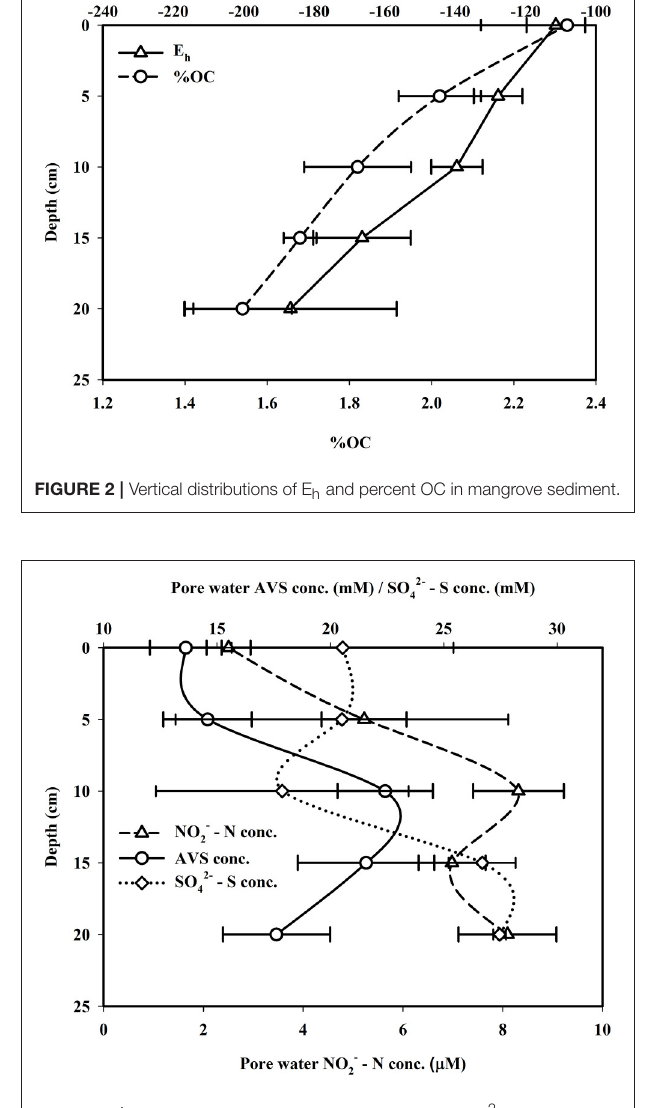
with patterns of peak sulfate reduction, with methanogenesis occurring deeper in the sediments (more discussion on this